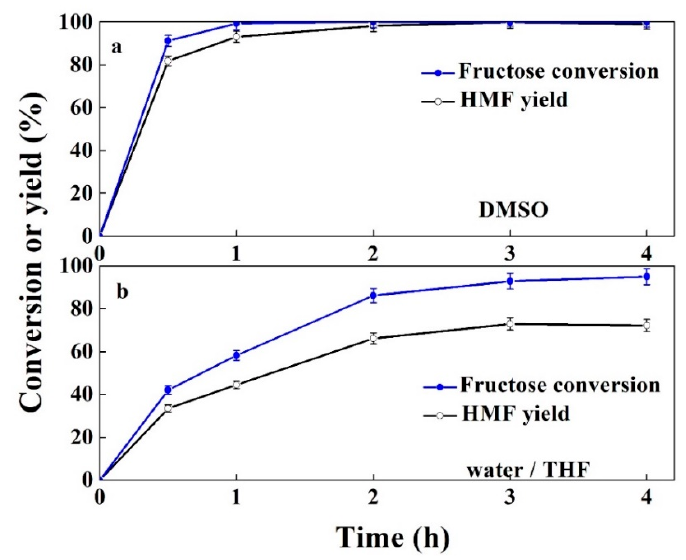
Figure 9. Fructose conversion and HMF yield under the catalysis of SPA-Imd-TinPCP in DMSO ( a ) and H 2 O / THF ( v / v 1:4) ( b ). The working pressures were 1 atm and 5 atm for DMSO and H 2 O / THF systems, respectively.